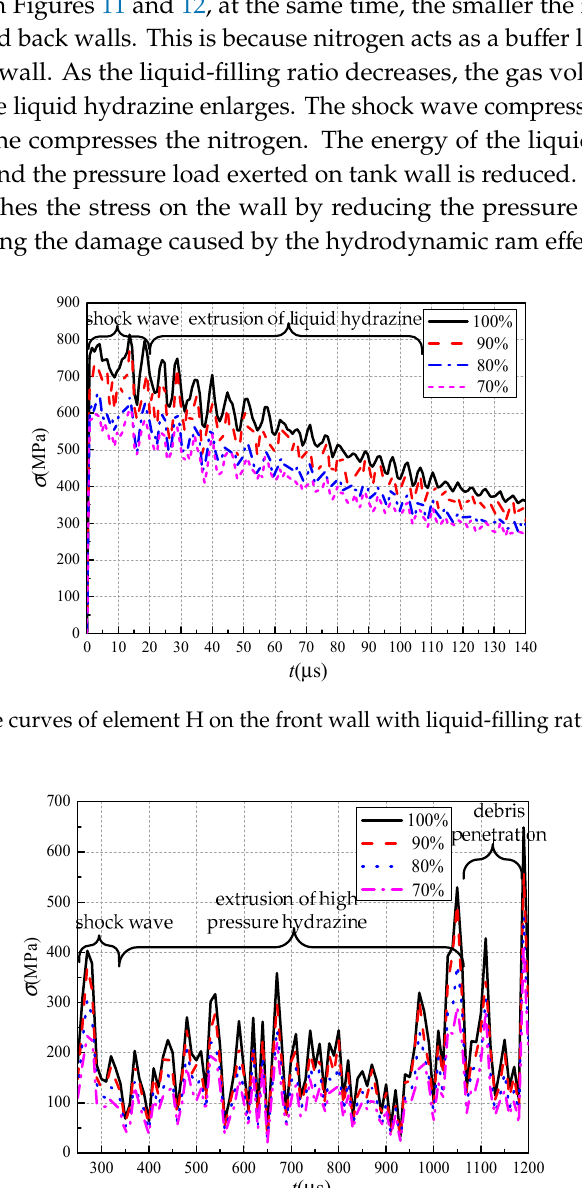
Figure 12. Stress–time curves of element I on the back wall with liquid-filling ratios of 70%, 80%, 90%, and 100%.